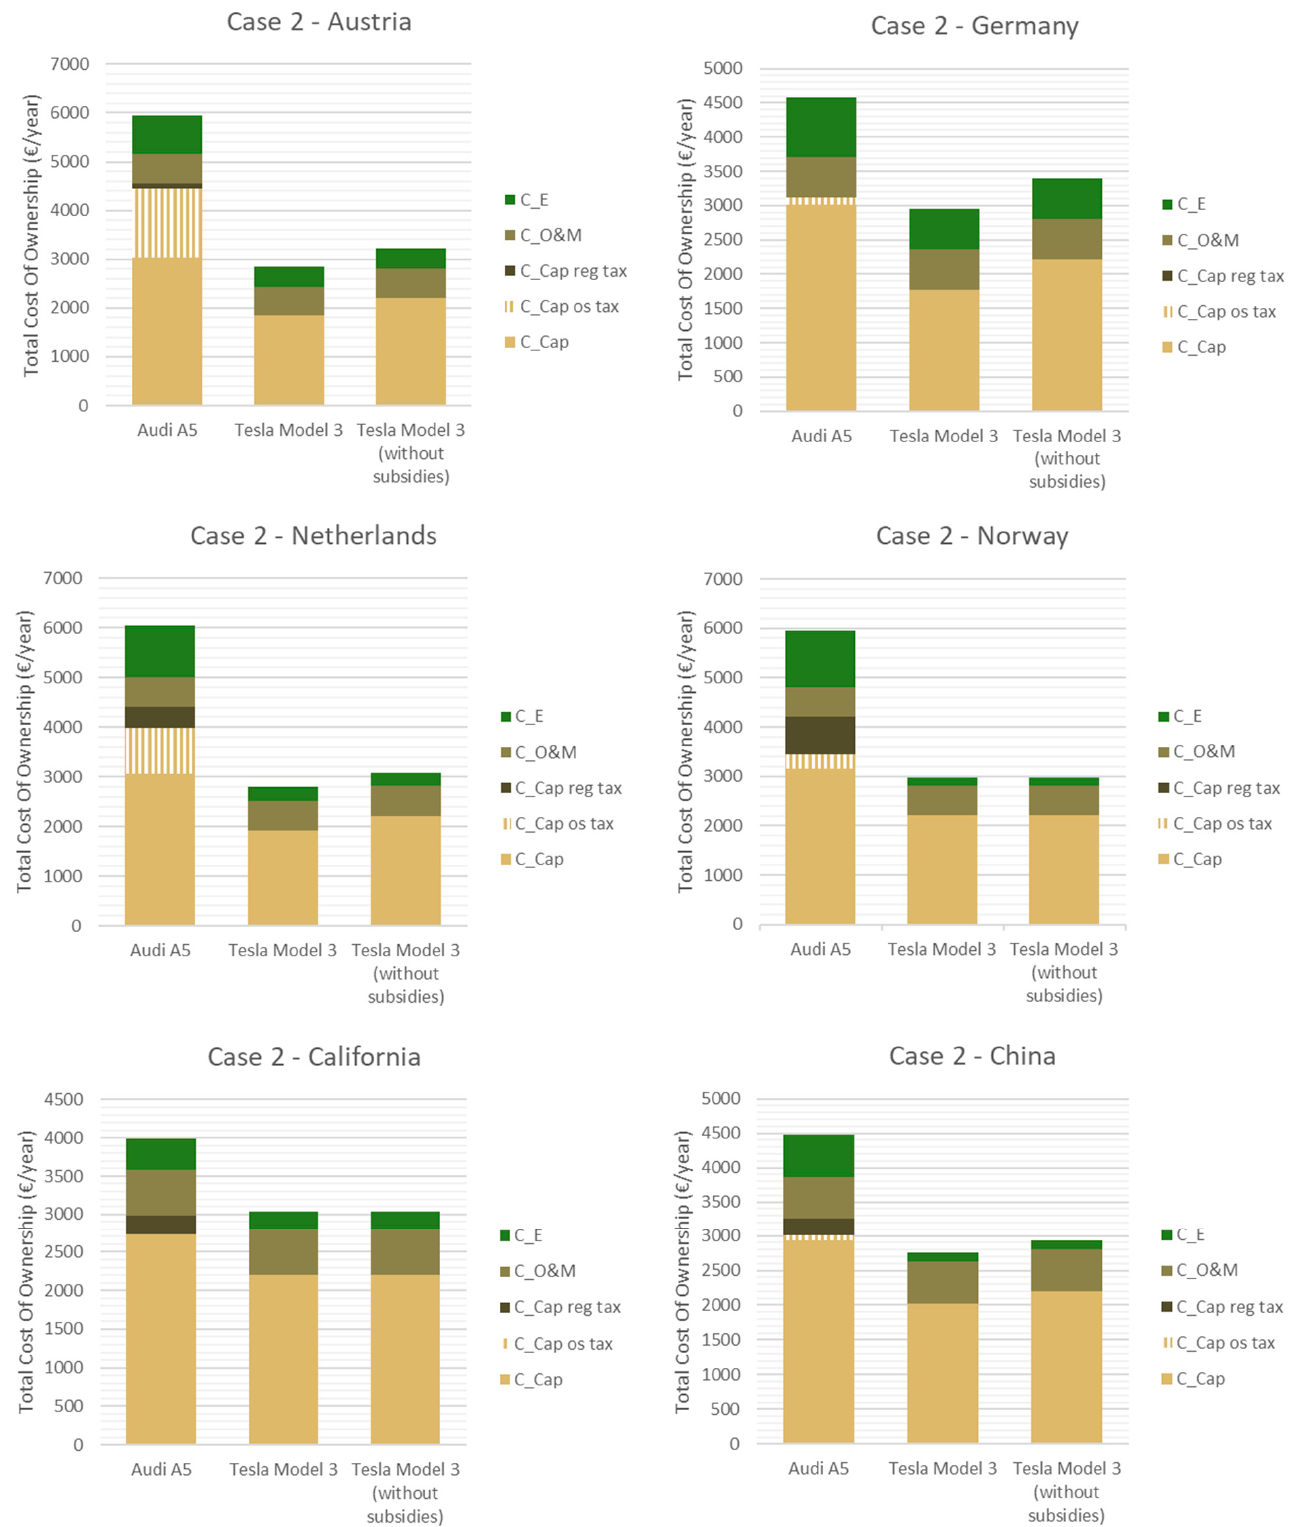
Figure 11. TCO: Case 2—Composition of the TCO in Case 2 for 2020.